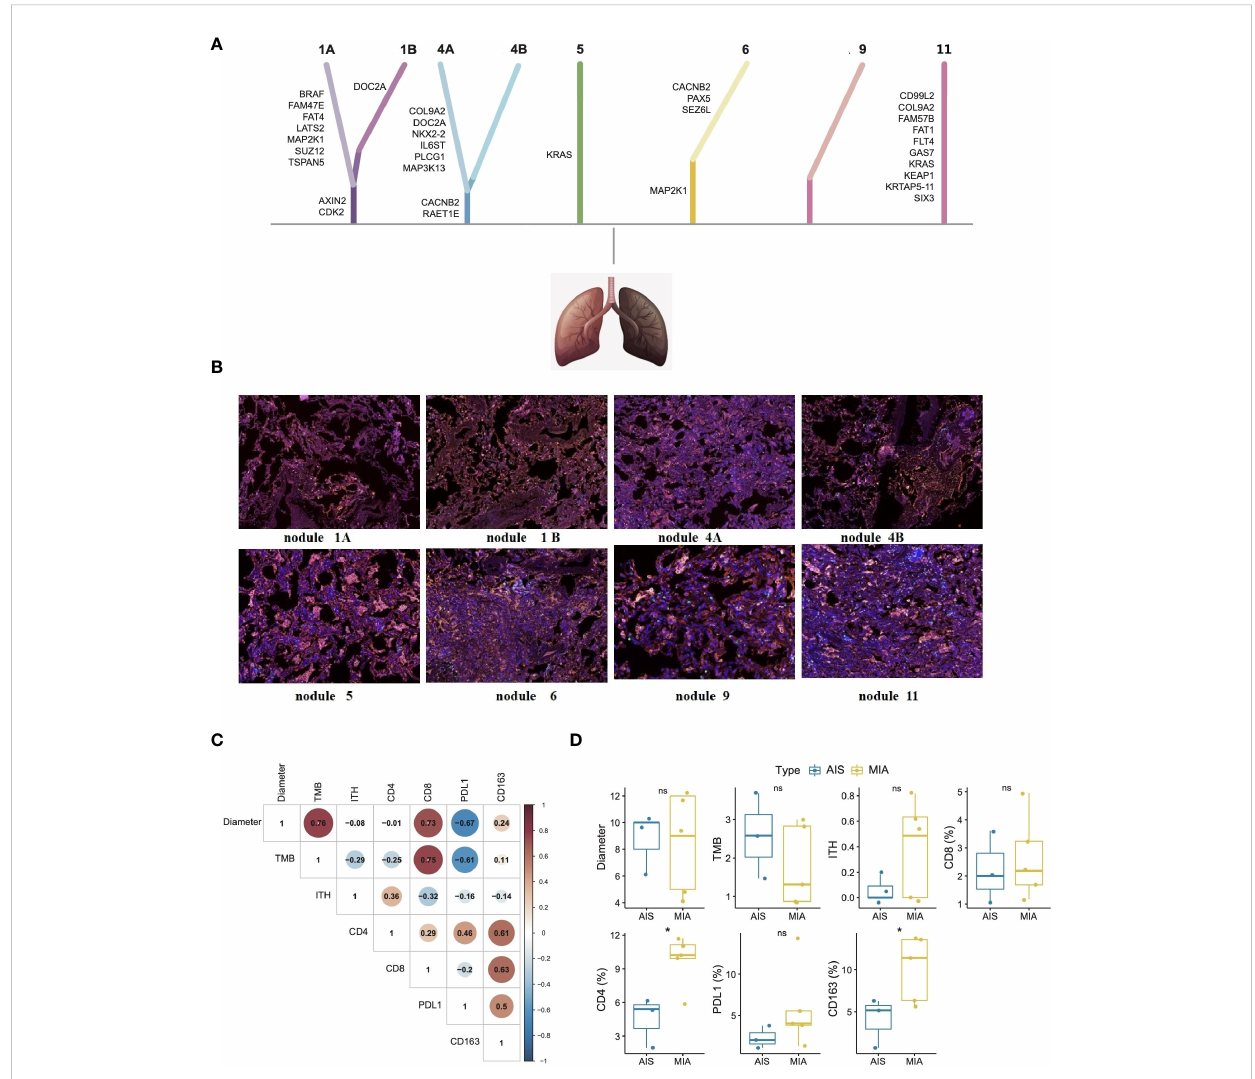
FIGURE 2 Whole-exome sequencing (A) , mIHC analysis (B) , biomarker correlations (C) , and subtype differences (D) of each nodule in this patient with early- stage MPLC. Whole-exome sequencing showed that there were almost no collective mutations among all nodules. mIHC analysis showed similarly low positive levels of CD4 + T cells (yellow color), CD8 + T cells (green color), CD163+ macrophages (purple color), and PD-L1 expression (red color) in tumor microenvironments of each nodule. Fisher ’ s exact test and Wilcox test were used to analyze the correlation or differences between different groups. *p<0.05 was considered as statistically signi fi cant. MPLC, multiple primary lung cancer; AIS, adenocarcinoma in situ; MIA, minimally invasive adenocarcinoma. ns, not statistically signi fi